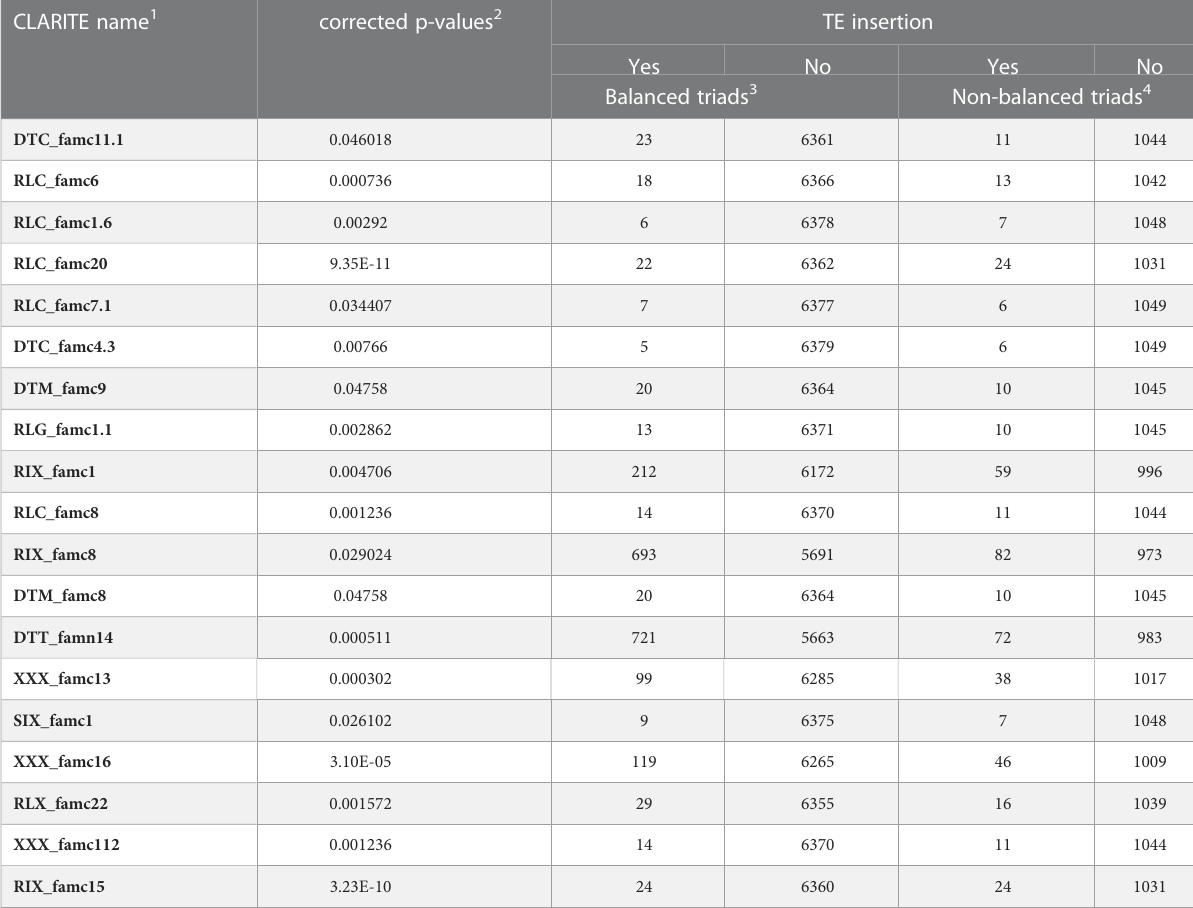
TABLE 3 TE subfamilies for which the presence/absence of TE insertion in at least one of the triad genes correlated with balanced relative expression of the three